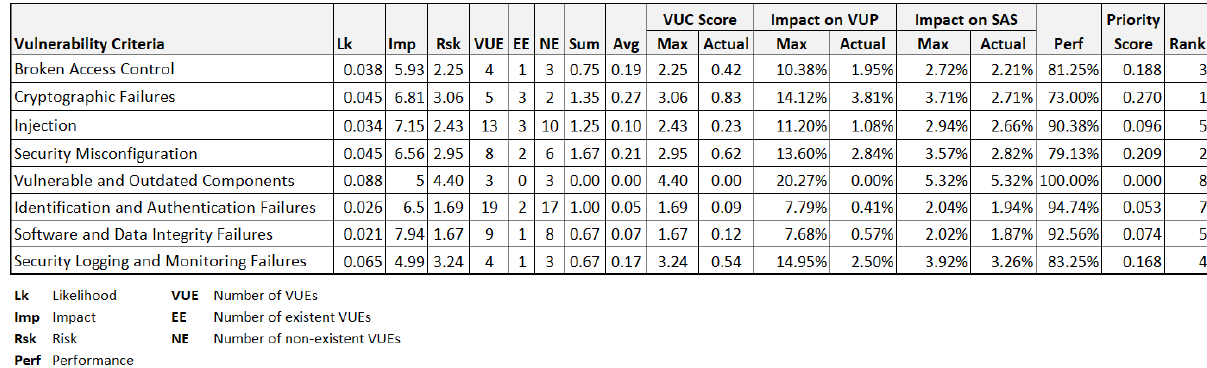
Figure 5. Security assurance scoreboard—vulnerability metrics.